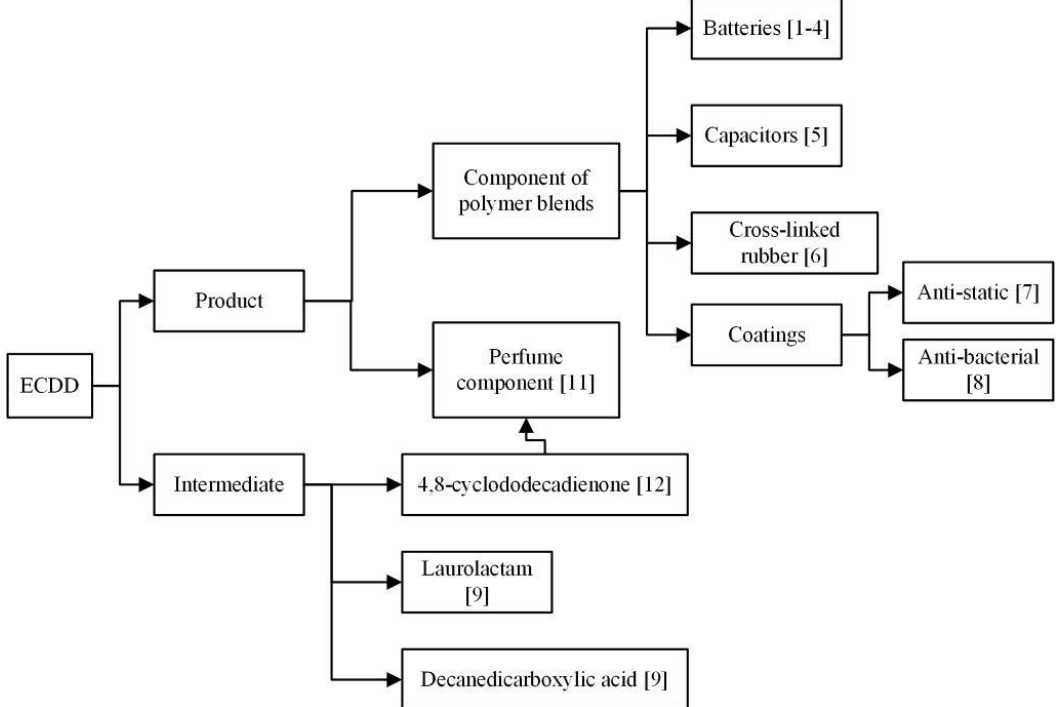
Figure 2. Applications of ECDD.